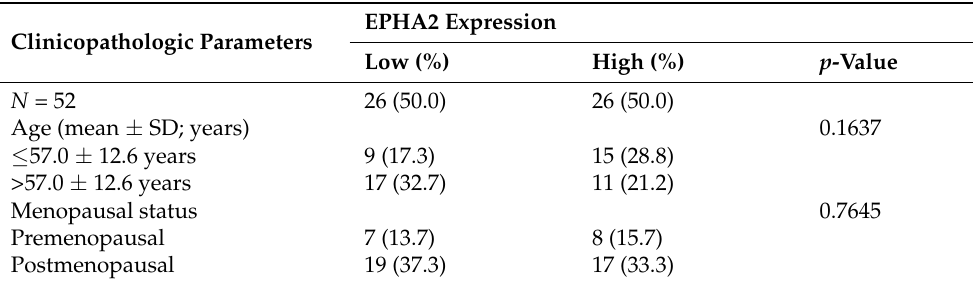
Table 1. Association of EPHA2 expression with selected clinicopathologic parameters in 52 triple- negative breast cancer (TNBC) patients ( p -values calculated through the Fisher’s exact